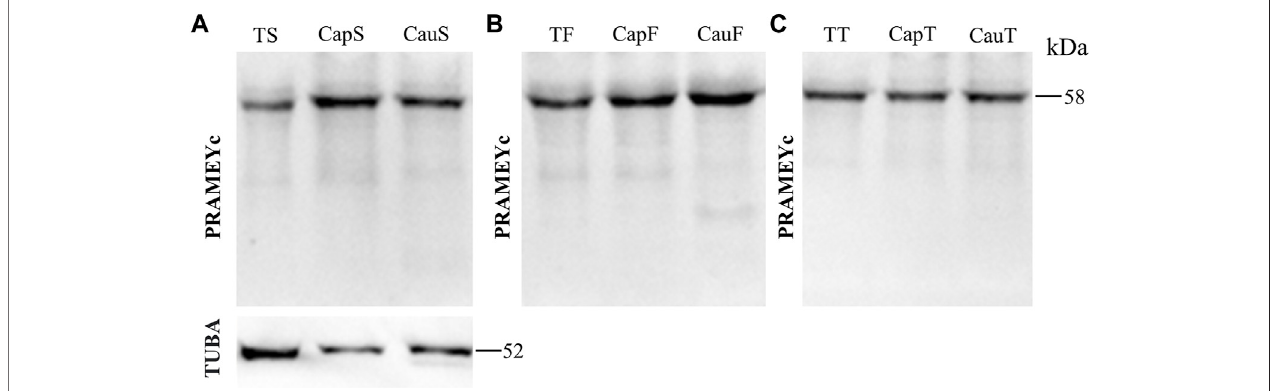
FIGURE5 | Expression of PRAMEYc in sperm, fl uid, and tissuecollected from thebovinetestis and caput and cauda segments ofthe epididymis. (A) Immunoblot of total testis sperm (TS), caput sperm (CapS), and cauda sperm (CauS) protein probed by the PRAMEYc antibody, then reprobed by α -tubulin (TUBA) antibody. (B)